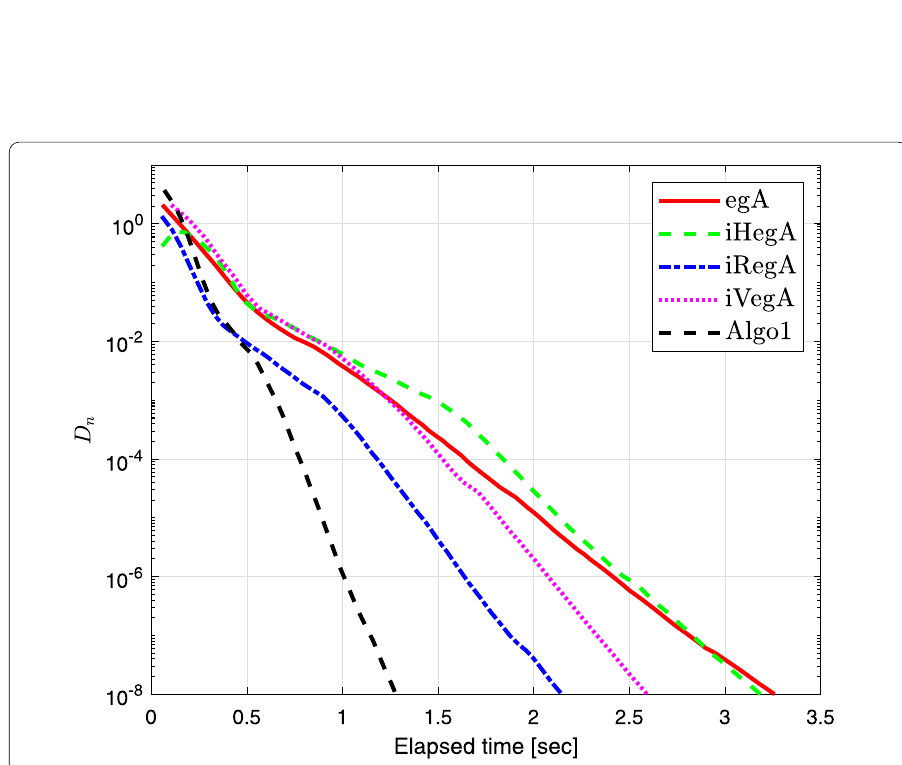
Figure 11 Example 5.3 when x 0 = (–1,2,0,3,4) T : the number of iterations is 87, 80, 60, 56, 53,